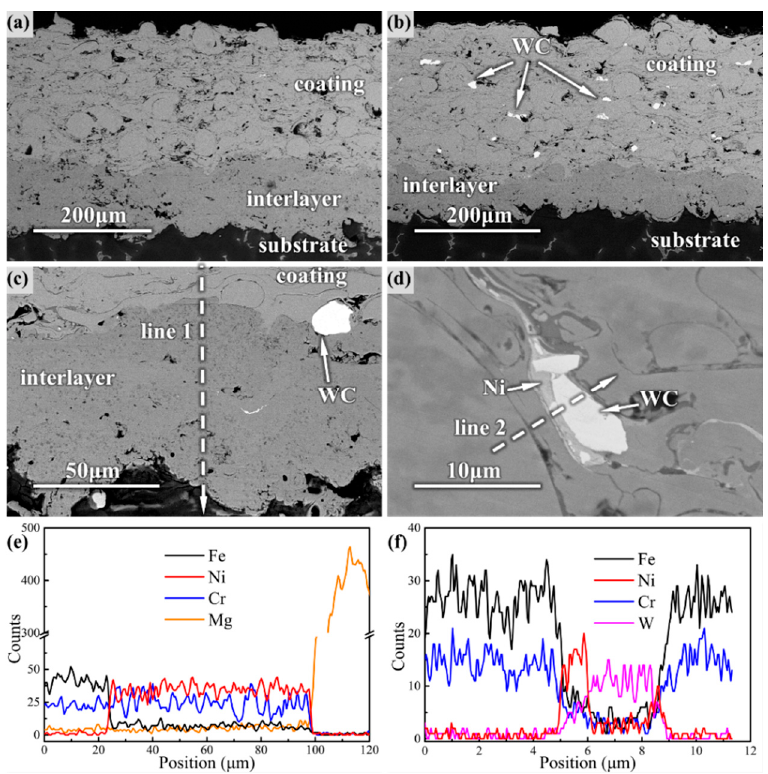
Figure 3. SEM morphology and EDS analysis of the coating cross-section: ( a ) SEM micromorphology of the amorphous coating; ( b ) SEM micromorphology of the composite coating; ( c , e ) interlayer elemental line scanning in the direction of line 1; ( d , f ) reinforcing phase particle elemental line scanning in the direction of line 2.